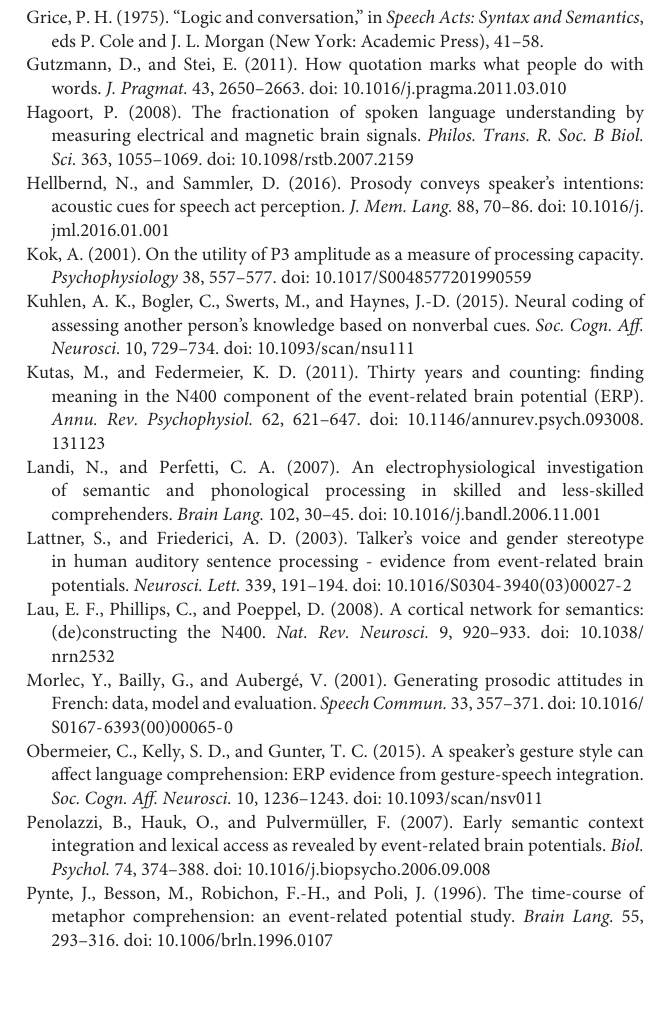
FIGURE S1 | Grand average ERPs to literal (black line) and ironic (blue line) sentence final words that were either cued (dotted line) or uncued (solid